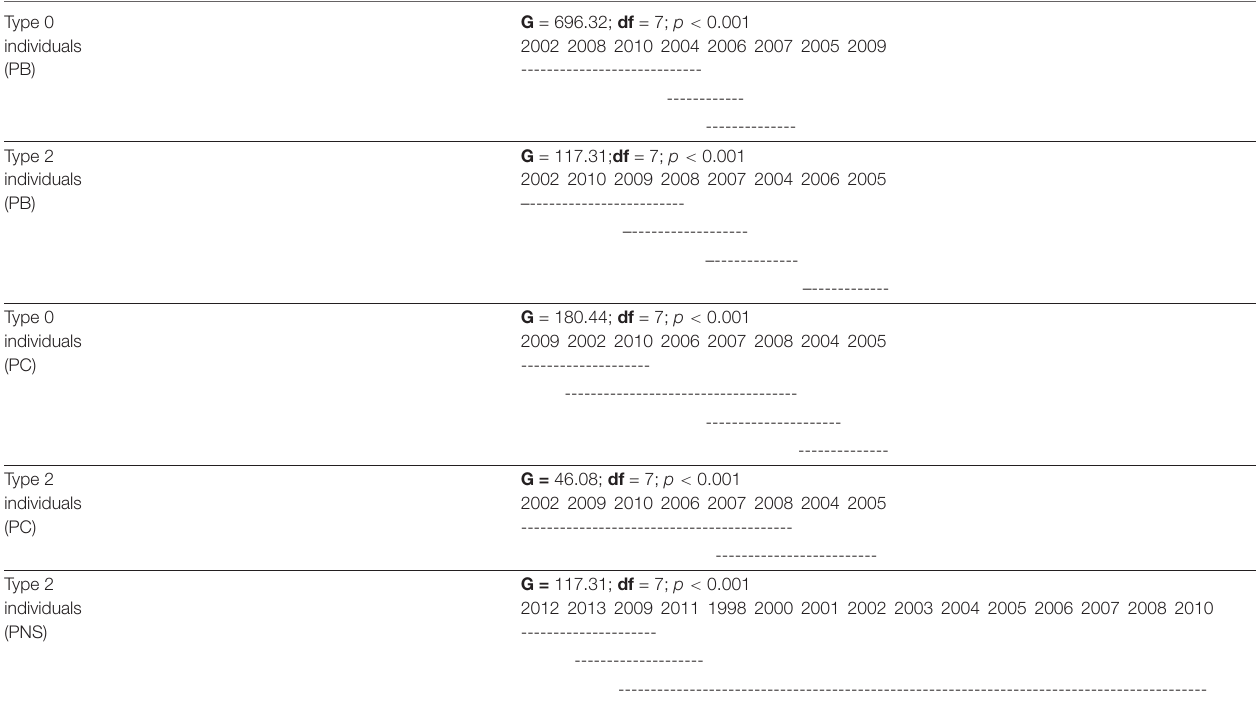
TABLE 2 | PB, PC, and PNS, abundance of type 0 and type 2 individuals in sampled